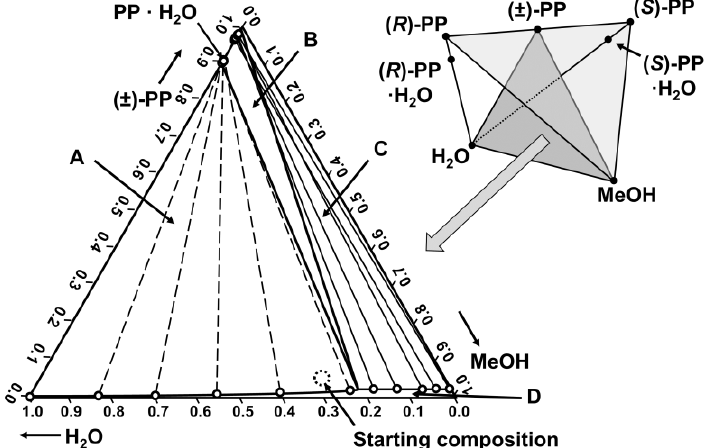
Figure 2. Solubility diagram of racemic phencyphos (PP), water and MeOH at 20 °C in weight fractions which is the middle section of the quaternary phase diagram depicted in the top-right corner. Region A: Solid PP·H 2 O (conglomerate) and solution. Note that the tie-lines depicted in this region radiate out of this plane towards the edges of the quaternary phase diagram where ( R )-PP·H 2 O and ( S )-PP·H 2 O are located, Region B: mixtures of anhydrous PP, PP·H 2 O and solution. Region C: Solid anhydrous PP (racemic compound) and solution. Region D: undersaturated solution. Open dots are measured points.